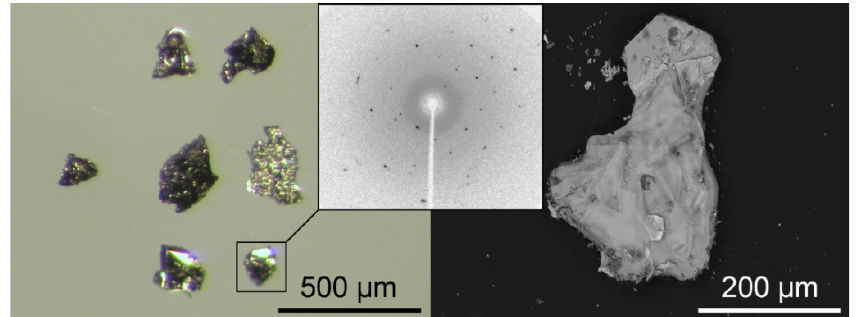
Na FFeAs viewed via an optical ( left ) and an electron 1 − x x